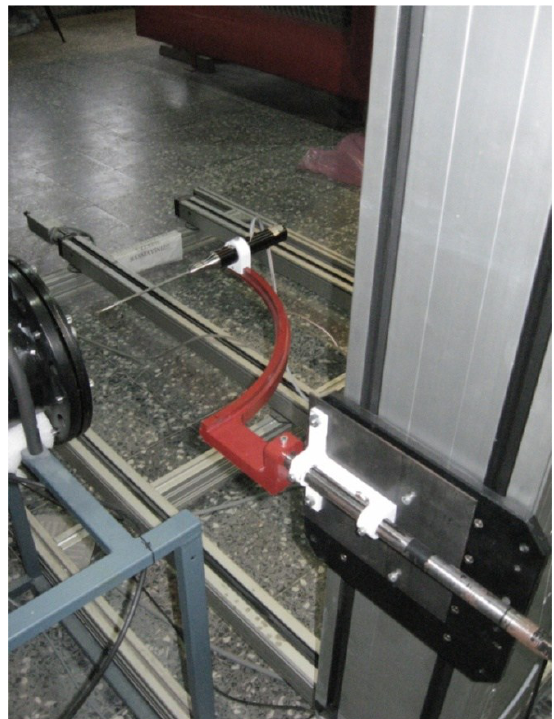
Fig. 3. Probe on the three directional traverse